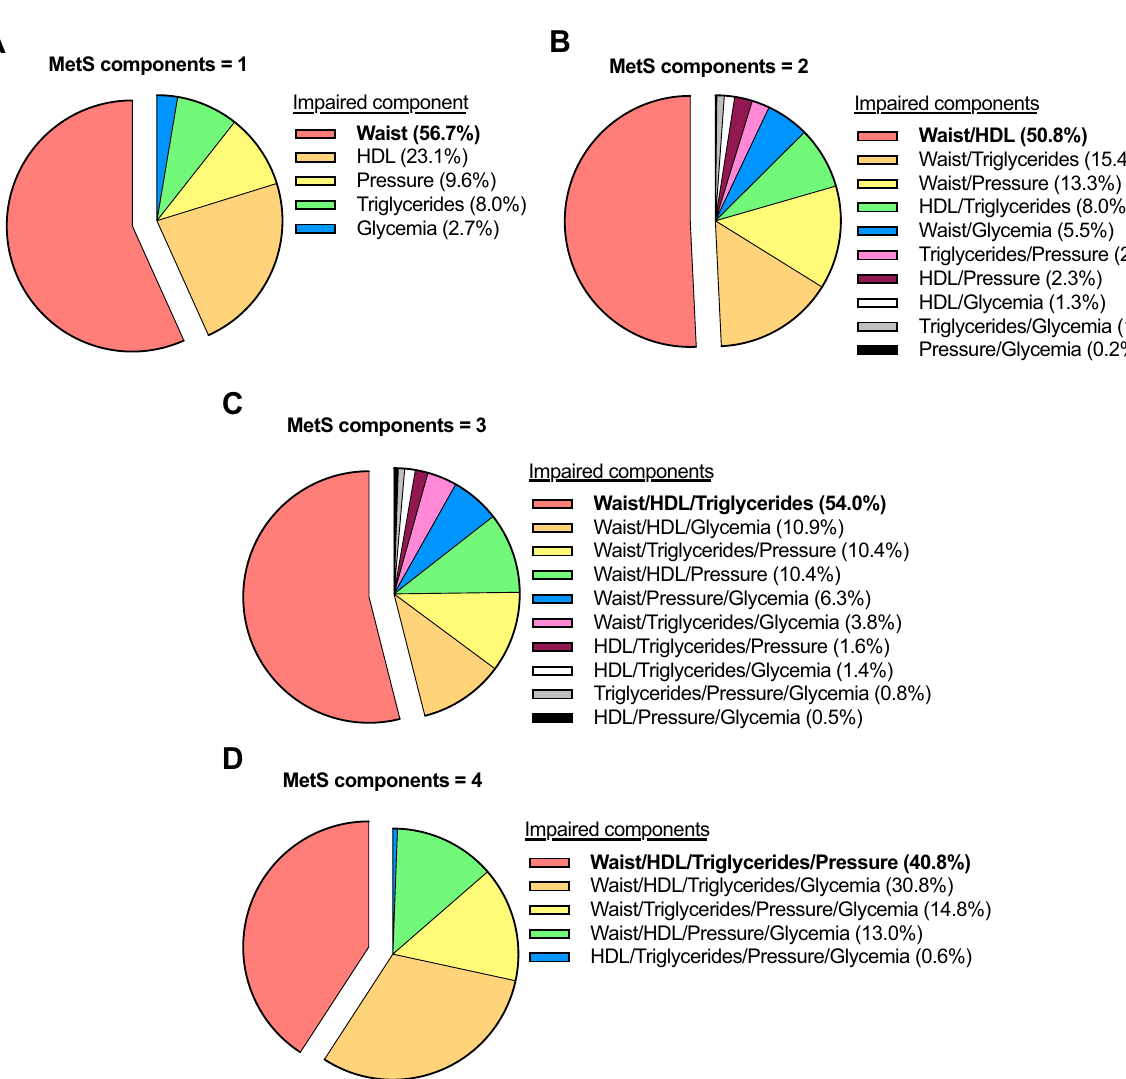
Figure 3 summarizes the most prevalent combinations of MetS components according to the number of com- ponents. The prevalence of subjects with zero components progressively decreased from Q1 to Q4 (Q1 30.0%, Q2